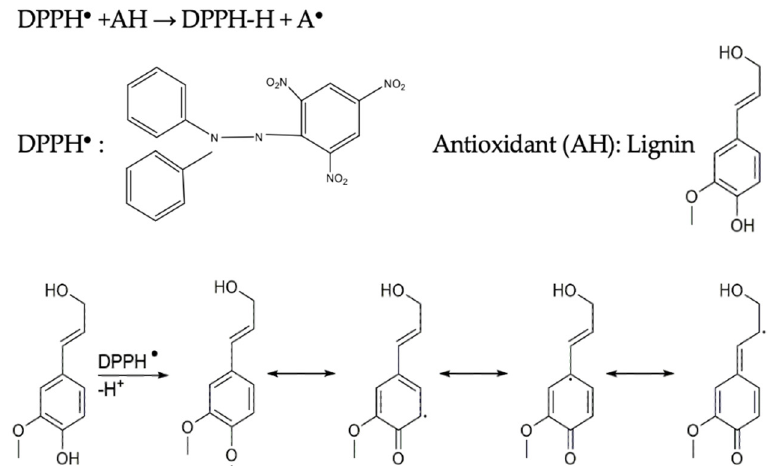
Figure 9. Trapping and stabilization of radicals by lignin.